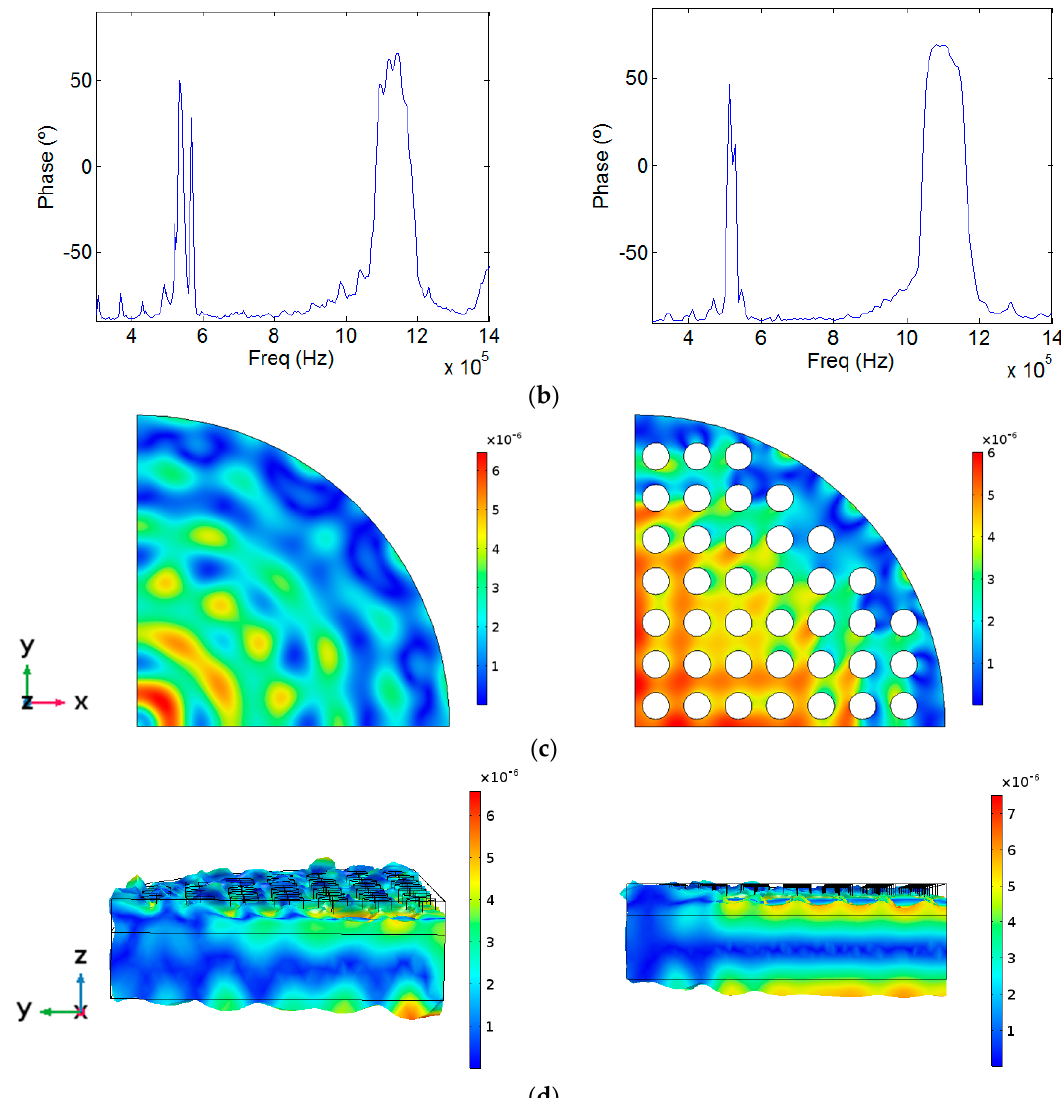
Figure 8. Simulations for Model 5 (left column) and Model 6 (right column) for a 1V excitation of the piezoceramic disc. Scales are in mm: ( a ) Model Setup, ( b ) Module of the input electrical impedance and phase, ( c ) Value of the out of plane component of the mechanical displacement at the aluminum surface for the resonance frequency (1.082 MHz for Model 5 and 1.042 MHz for Model 6) and ( d ) Value of the maximum out-of-plane vibration amplitude in the yz section of the transducers for the resonance frequency.